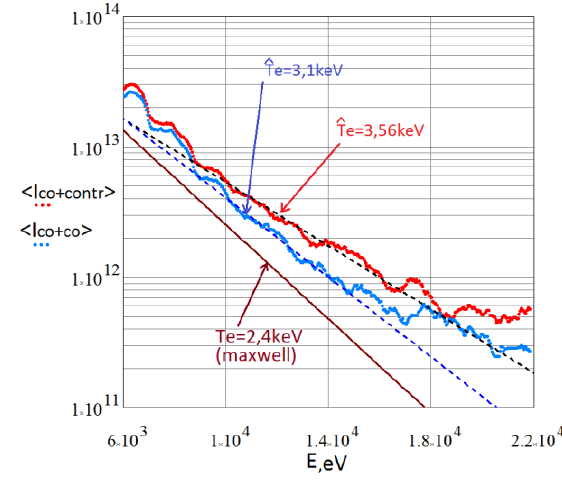
Fig.13. Approximated values of “electron temperature”. Brown line corresponds to the temperature for Maxwellian